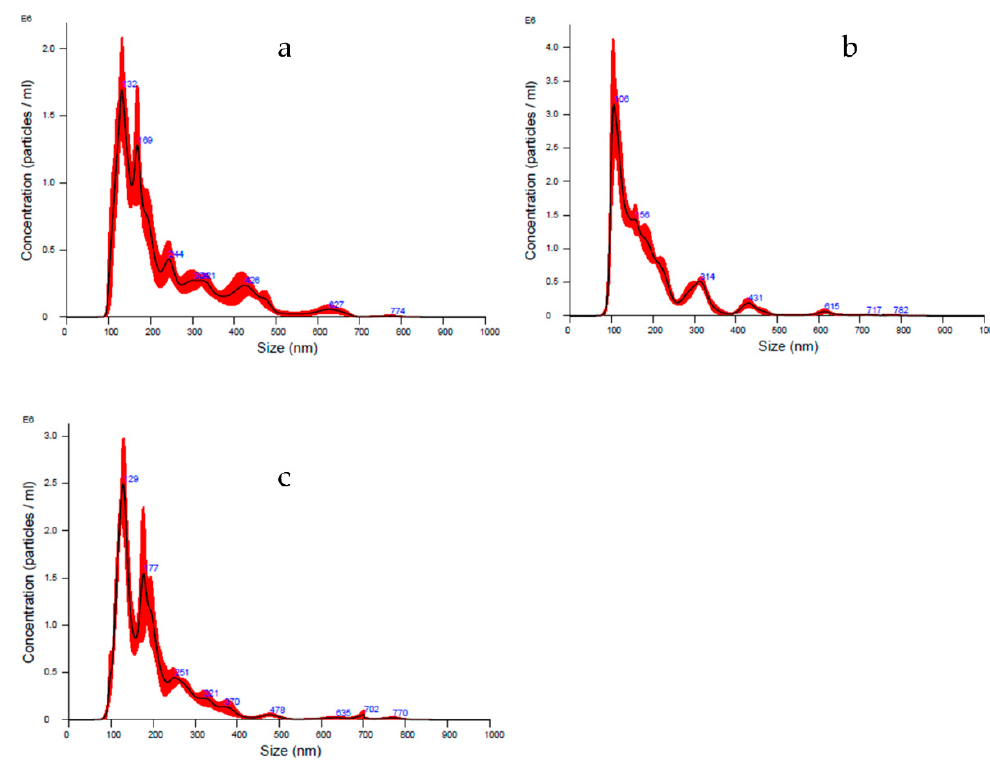
Figure 1. NTA averaged curves as particles concentration and size distribution of batch 1 ( a ), 2 ( b ), and 3 ( c ), respectively.